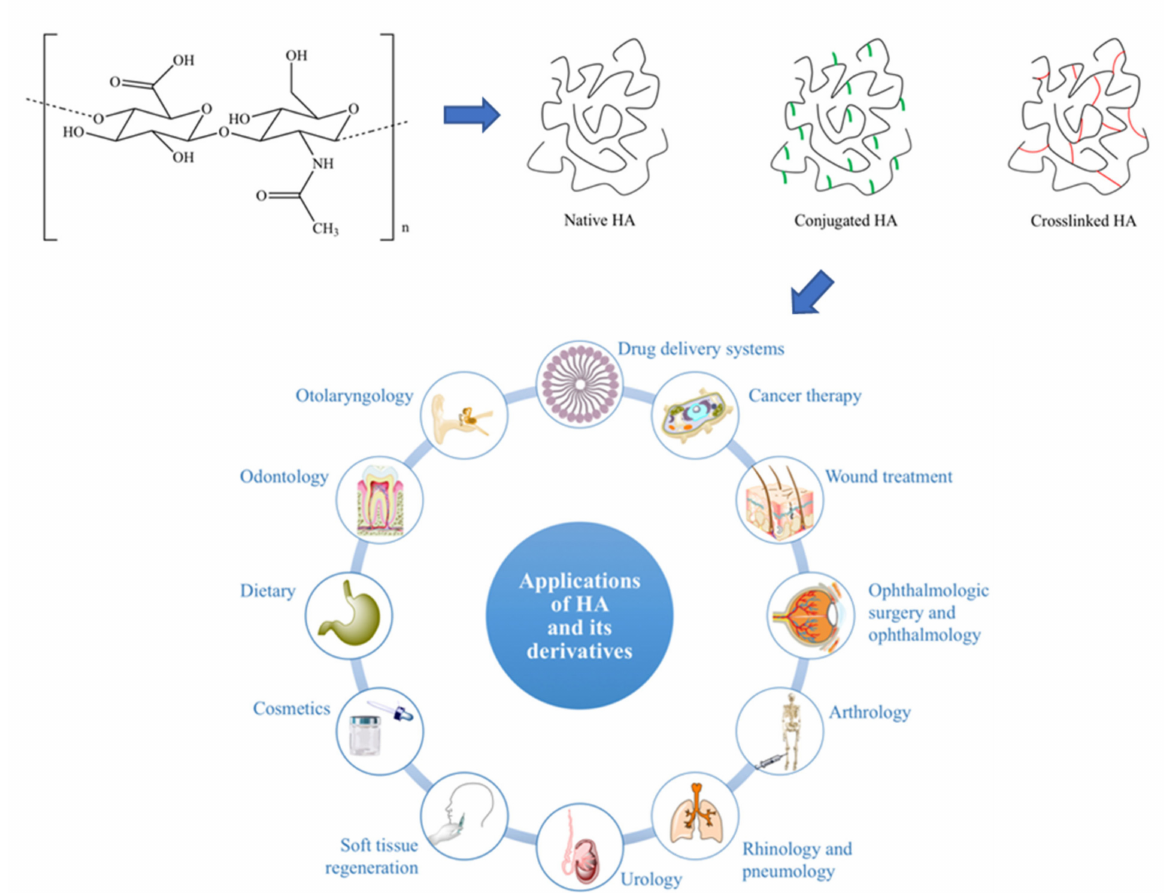
Figure 6. The popular modifications and potential biomedical applications of hyaluronic acid. Used with permission from Fallacara et al. [142]. Copyright © 2021 by the authors. Licensee MDPI, Basel,